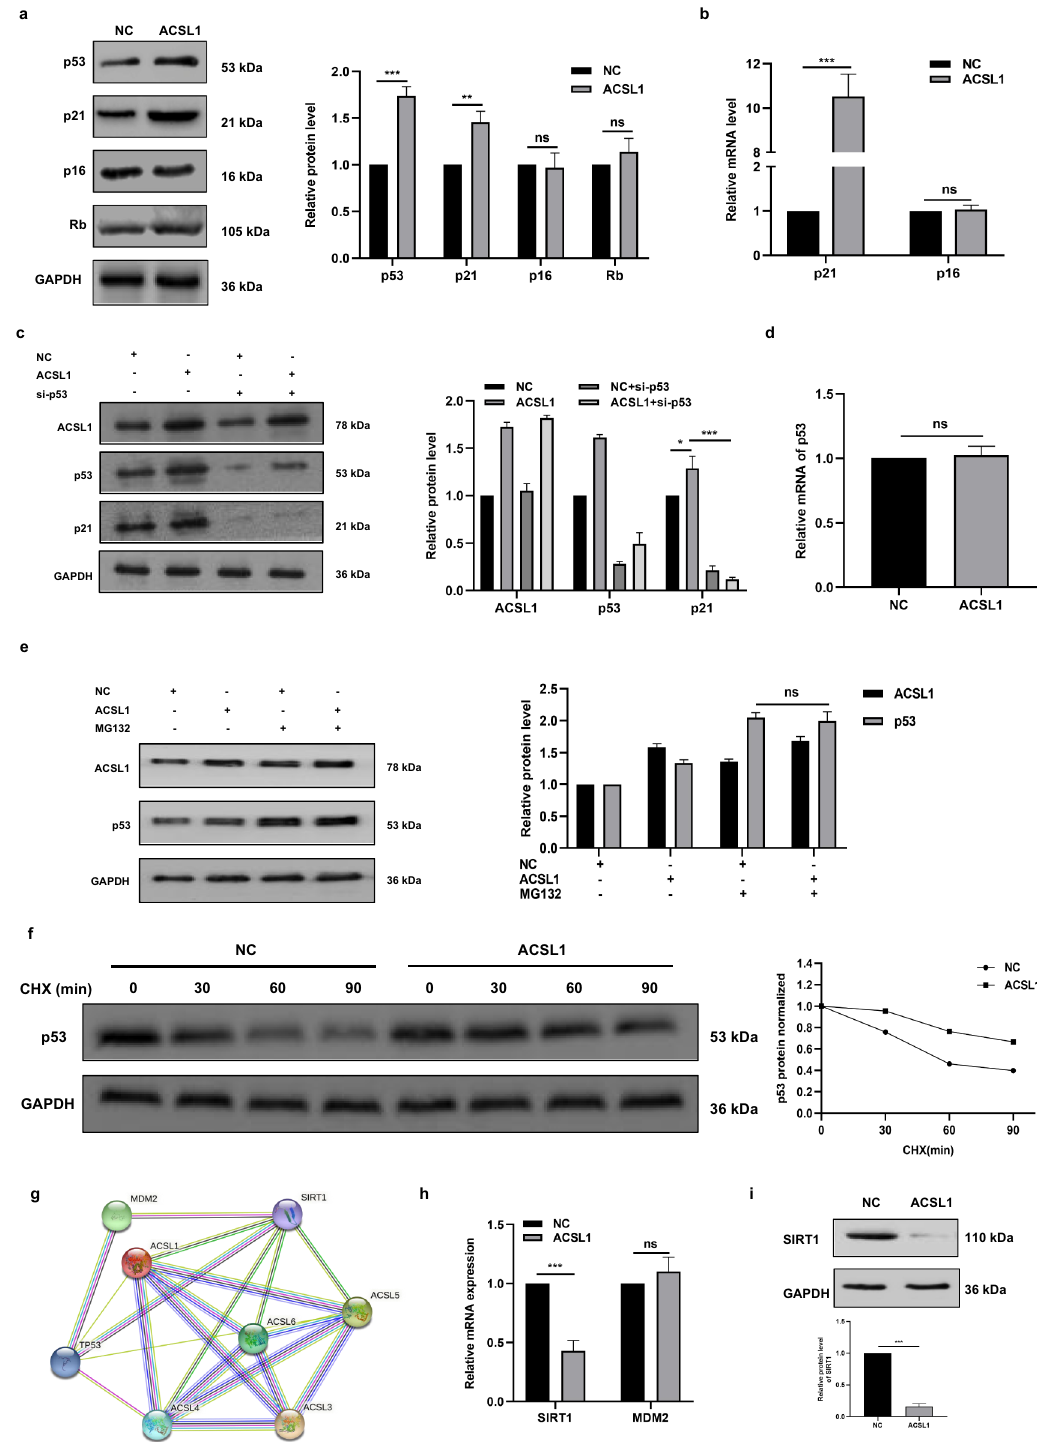
Figure 4. ACSL1 induces senescence through SIRT1/p53/p21 pathways in K562 cells. ( a ) Western blot analysis of the expression levels of senescence related proteins (p53, p21, p16, Rb) after transfection with ACSL1 in K562 cells. ( b ) qRT-PCR was applied to quantify the relative mRNA expression of p21 and p16. ( c ) Western blot detected the expression levels of ACSL1, p53, and p21 in four groups K562 cells. ( d ) qRT-PCR was applied to quantify the relative mRNA expression of p53. ( e ) Western blot assays for ACSL1 and p53 expression in K562 NC and ACSL1 cells treated with MG132. ( f ) Western blot assays for p53 expression in K562 NC and ACSL1 cells treated with CHX. ( g ) The protein–protein networks view from STRING database showing the networks of ACSL1, p53, and SIRT1. ( h ) The mRNA levels of SIRT1 and MDM2 after transfection with ACSL1 in K562 cells. ( i ) The protein levels of SIRT1 after transfection with ACSL1 in K562 cells. *p < 0.05, **p < 0.01 and ***p <